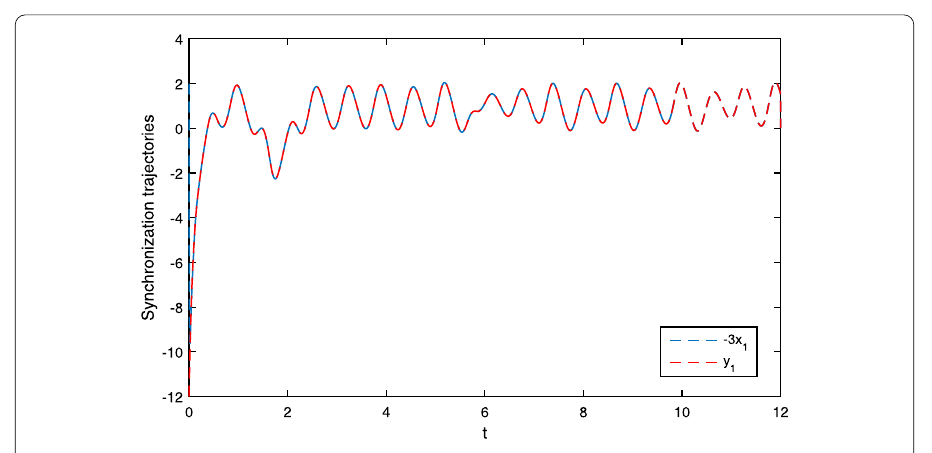
Figure 6 The synchronization trajectories of x 1 , y 1 with β = –3